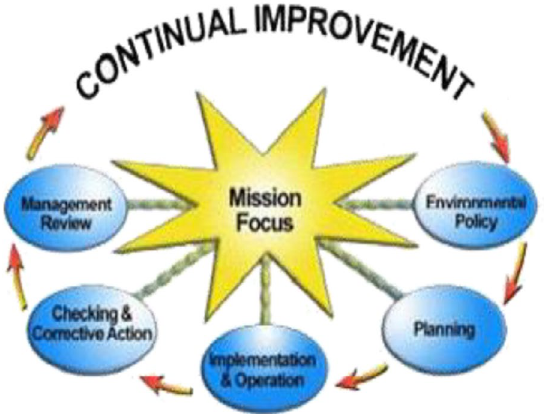
Fig. 3: Continuous improvement of the US Army EMS (Source: US Army-Environmental Center, 2004)